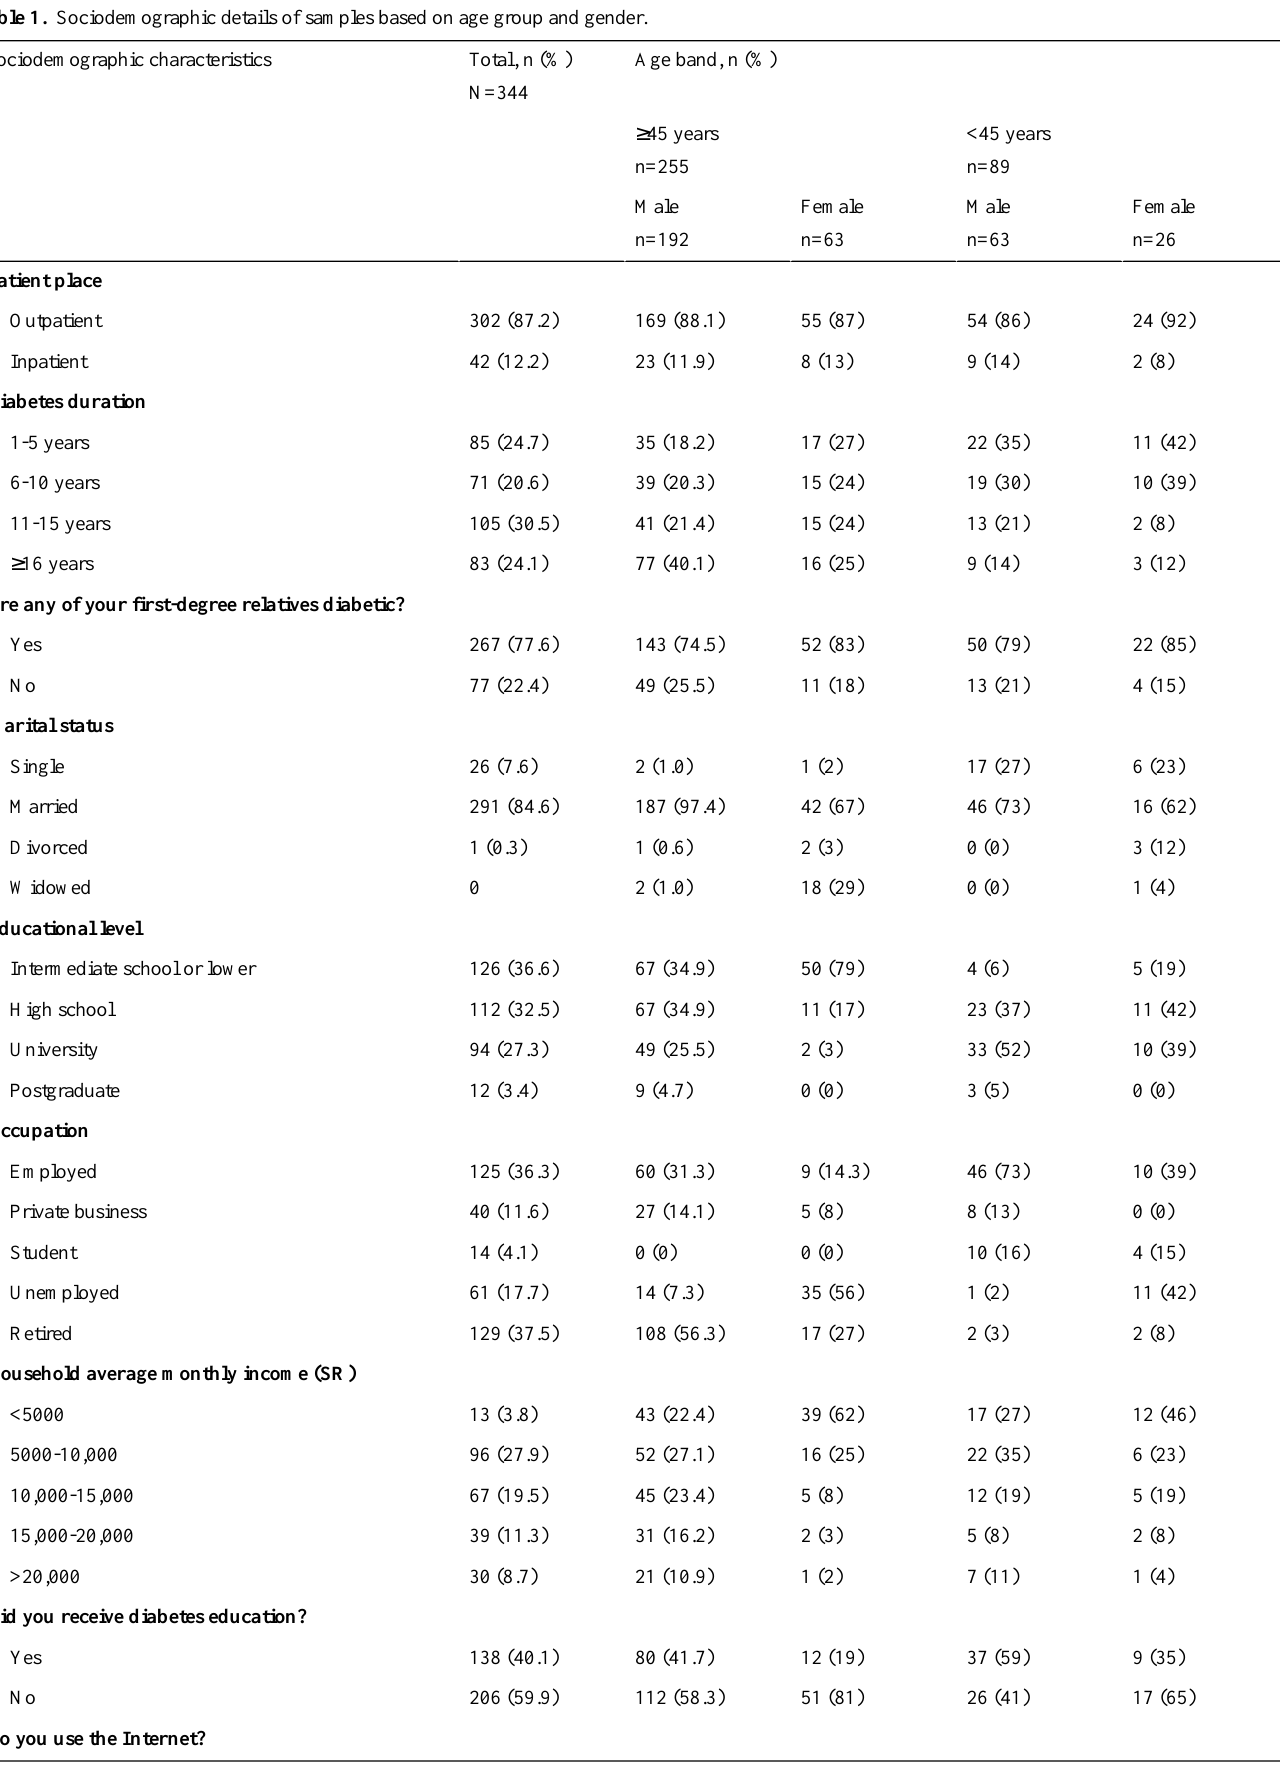
Table 1. Sociodemographic details of samples based on age group and